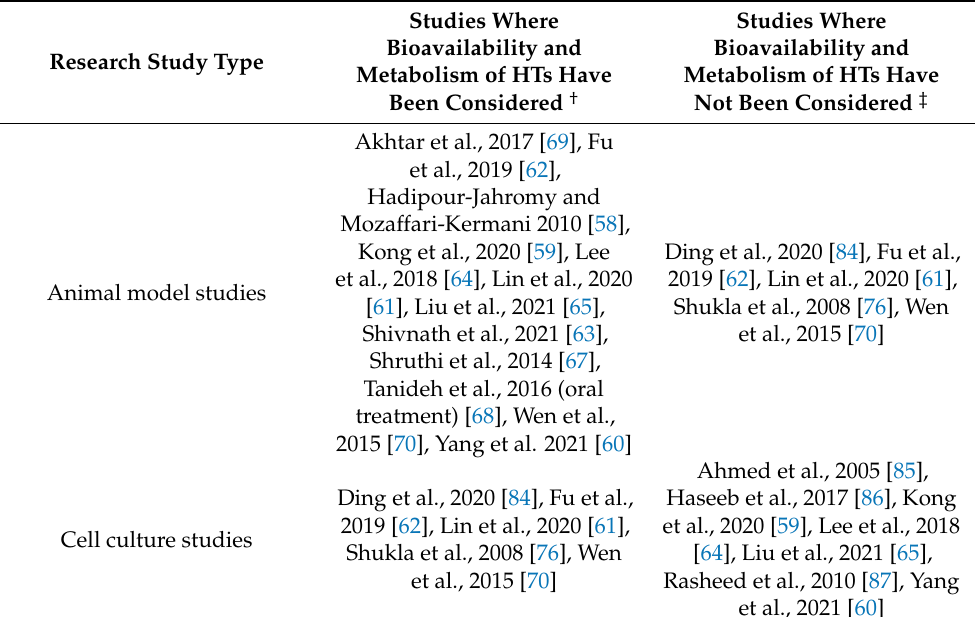
Table 5. Published animal model and cell culture studies on the potential beneficial effects on OA of HT-containing products where biotransformation of HTs into derived metabolites has been evaluated or taken into